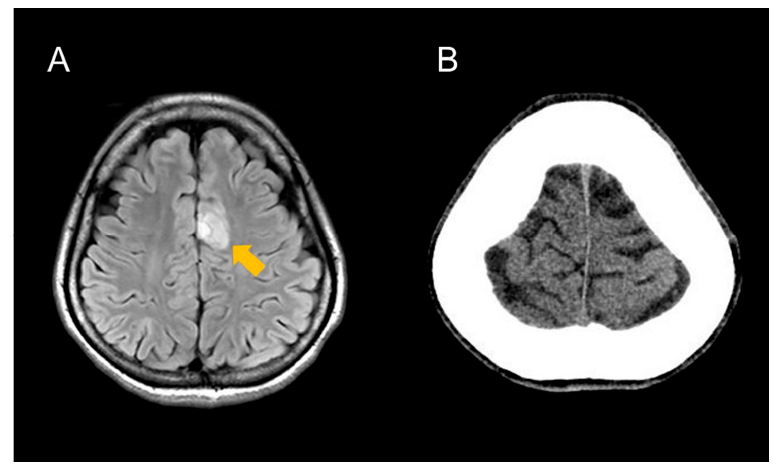
Figure 1. Preoperative MRI ( A ) and CT ( B ) images of the patient. All magnetic resonance examinations in this study were performed with a 3 ‐ T MR system (Vantage Centurian, Canon Medical Systems Corporation, Otawara, Japan). The fluid ‐ attenuated inversion recovery (FLAIR) image revealed high intensity mass (arrow) in the left cingulate gyrus. The CT image revealed that the maximum thickness of the frontal bone was 28 mm, which might be associated with the epileptic discharges being unclear based on scalp EEG. The following are the surgical procedures: During the surgery, the EEG (EEG ‐ 1260; Nihon Kohden, Co., Tokyo, Japan), motor ‐ evoked potentials (MEP), and somatosensory ‐ evoked potentials (SEP) were used for neuromonitoring. The patient was placed in the Brain Sci. 2022 , 12 , x FOR PEER REVIEW supine position. The head was fixed in the median and vertex ‐ up positions after general anesthesia was induced. Sevoflurane was used to maintain anesthesia so that epileptic discharges could be easily detected with EEG. The reference electrode was placed on her forehead for the referential recording of EEG. The brain surface was exposed following the frontal craniotomy. First, the location of the central sulcus was identified using MEP and SEP to not injure the precentral sulcus. Then, using the navigation ‐ guided method, three deep electrodes with six electrodes each (Unique Medical Co., Ltd., Tokyo, Japan) were inserted into the tumor’s anterior, posterior, and lateral margins (Figure 2). The depth of each deep electrode corresponded to the depth of the tumor: the depths of anterior, posterior, and lateral electrodes were 39, 40, and 35 mm from the brain surface, respectively. We used the following montages: referential recording, bipolar recording, and average potential reference. As a result, numerous epileptic discharges were detected according to referential recording and average potential reference (Figure 3A), and the highest peak originated from the fourth electrode of the anterior deep electrode according to bipolar recordings (Figure 3B,C). The tumor was resected using the superior frontal gyrus as a surgical window. Based on the EEG results, ahead of the tumor was extendedly resected because the anterior cingulate gyrus and superior frontal gyrus are considered non ‐ eloquent areas. Epileptic discharges were eliminated following tumor resection using a subdural grid electrode placed on the brain surface around the cavity (Figure 4). The MEP did not reveal any changes during the surgery.